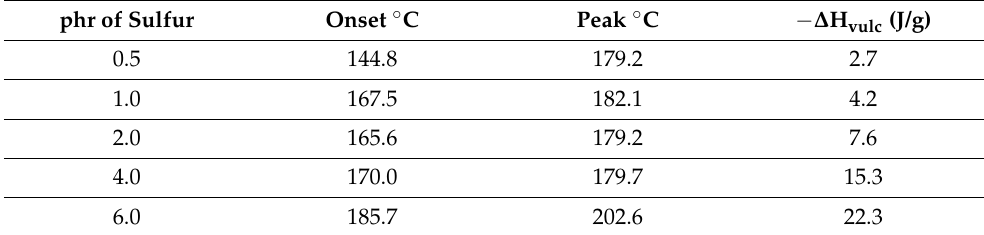
Table 2. Vulcanization enthalpy of NR-rubber compounds of reported in Table 1 heating rate 10 ◦ C/min in sealed Al crucible.